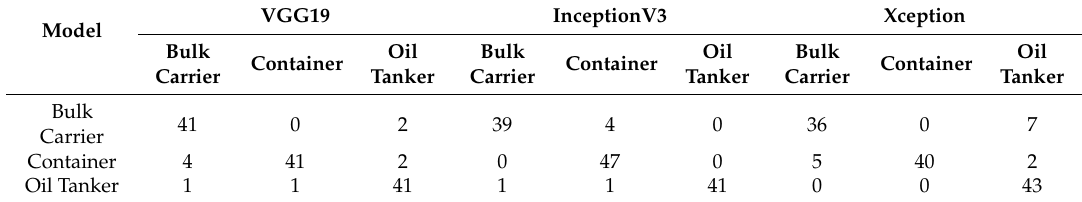
Table 9. Confusion matrix of the model based on VGG19, InceptionV3, and Xception.